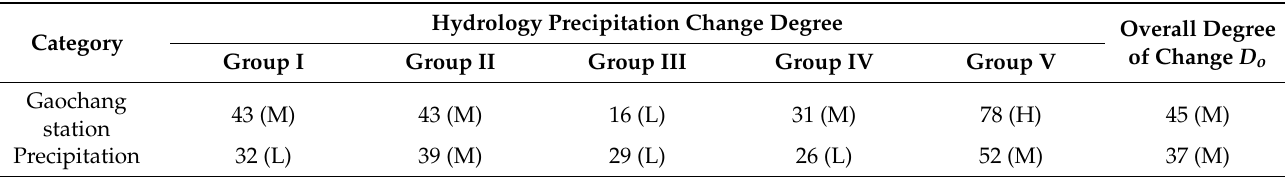
Table 4. Overall Min River discharge and precipitation change degree.